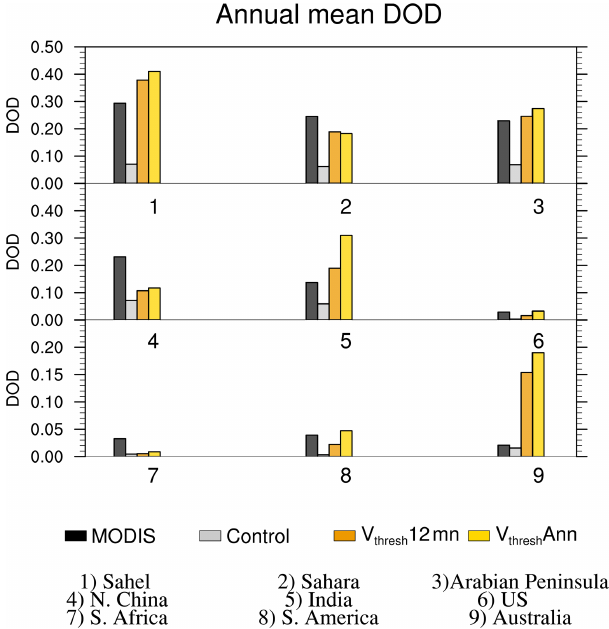
Figure 8. Regionally averaged annual mean DOD (2003–2015) over nine regions from the Control (grey), V thresh 12mn (orange), and V thresh Ann (yellow) simulations and MODIS